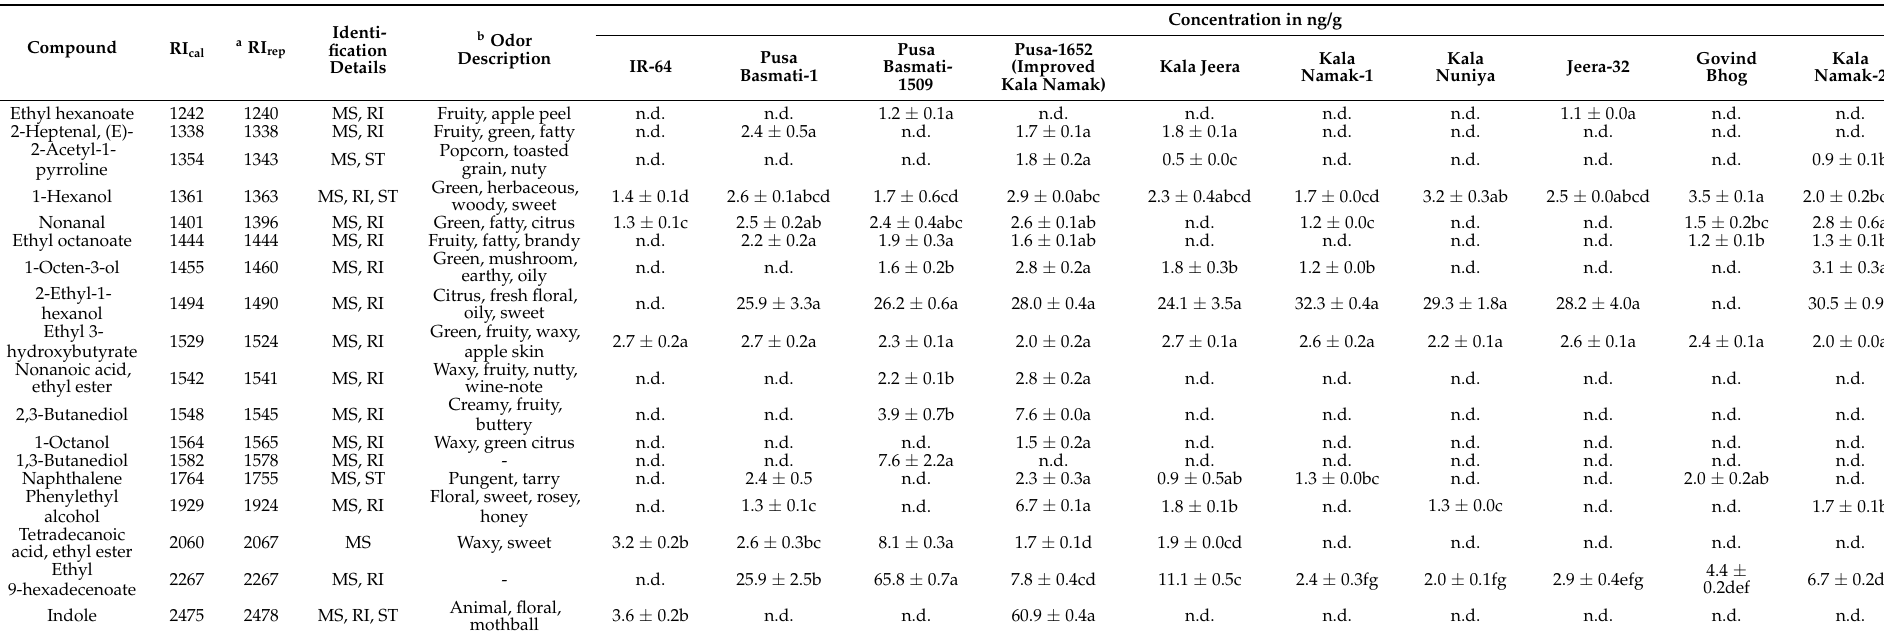
Table 1. Identified major volatile compounds and their relative levels in raw rice samples of ten traditional and improved